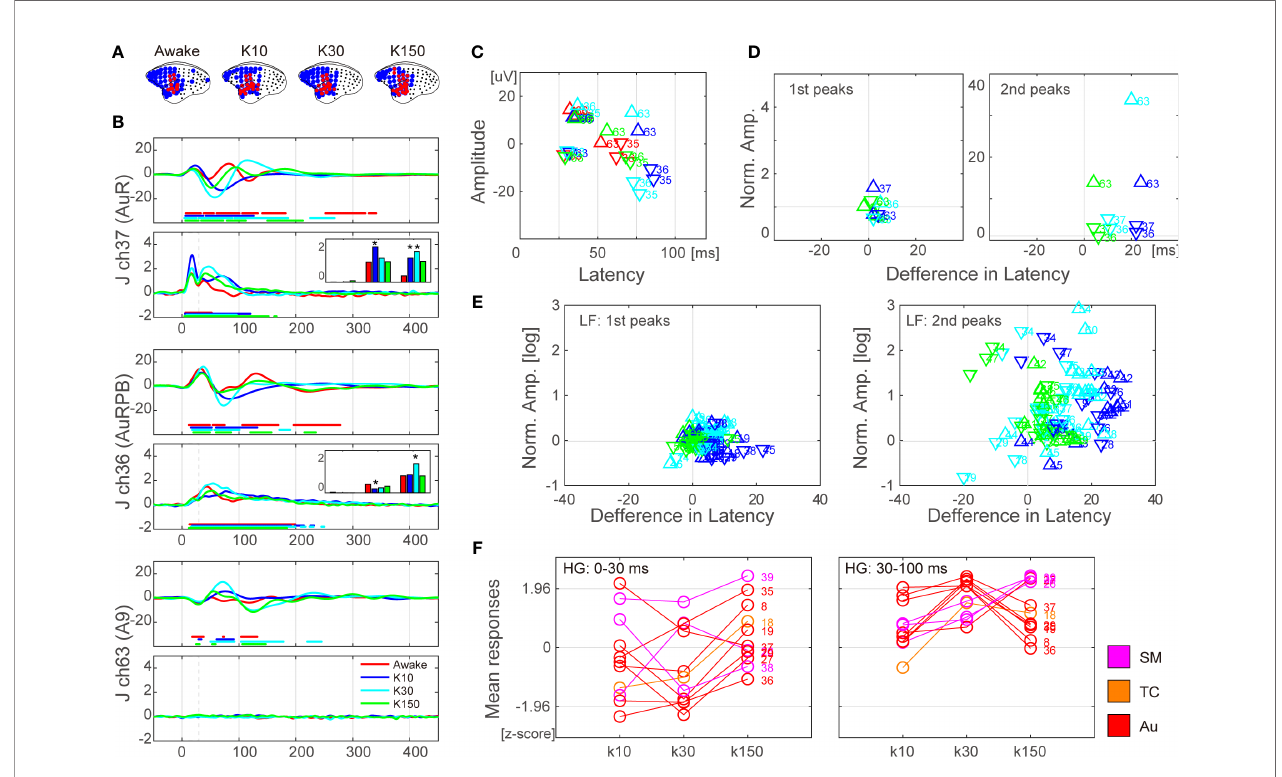
FIGURE 4 | The effects of ketamine on auditory evoked neural responses over time following ketamine administration in monkey J. (A) Changes in cortical maps for auditory information processing of LF (blue) and HG (red). Data were acquired form monkey J. (B) Representative waveforms from electrodes in auditory (ch37 and ch36) and prefrontal (ch63) cortices. The top and bottom insets show LF and HG, respectively. The line color indicates the conditions of the recordings, and the dots represent signi fi cant time points. (C) The amplitudes and latencies of the 1st and 2nd peaks of LF of the selected electrodes. The marker color indicates the conditions of the recordings. The triangles represent positive peaks, and the inverted triangles represent negative peaks. (D) Normalized amplitudes and latencies of the 1st (left) and 2nd (right) peaks of the selected electrodes. (E) Normalized amplitudes and latencies of the 1st (left) and 2nd (right) peaks of all electrodes. The amplitudes are log scaled. (F) Changes in responses of HG at 0 – 30 ms (left) and 30 – 100 ms (right) after the sound onset. The bar plots in (B) show these values of the corresponding electrodes. Asterisks in the bar plots indicate signi fi cant (>2)